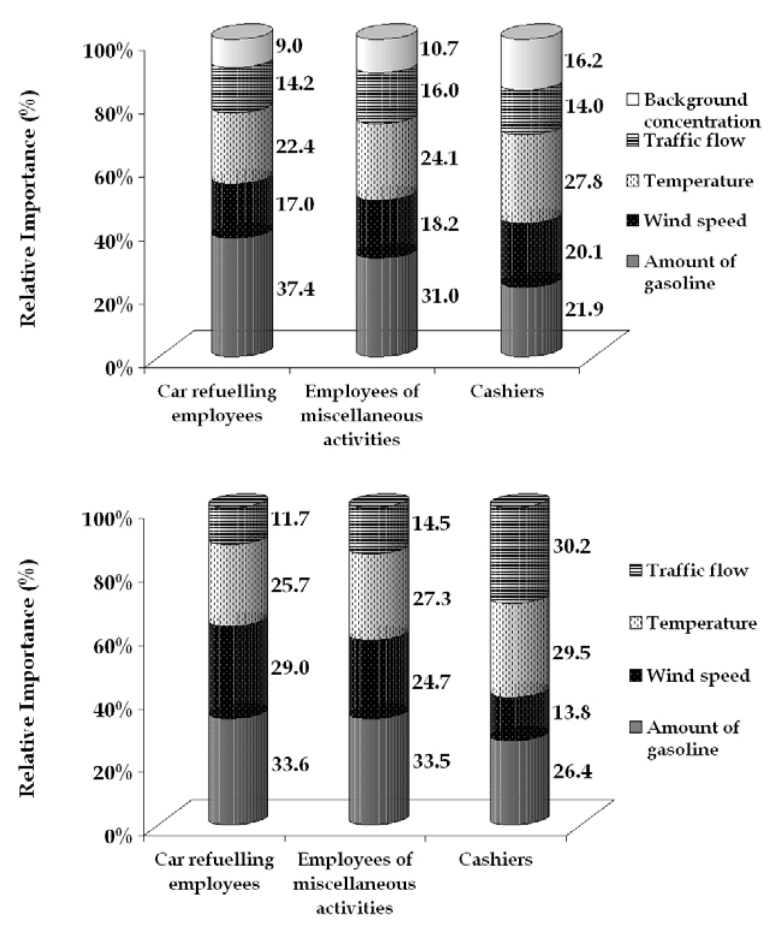
Figure 9. Relative importance of the parameters constituting the exposure pattern of the employees of urban (a) and rural (b) filling station